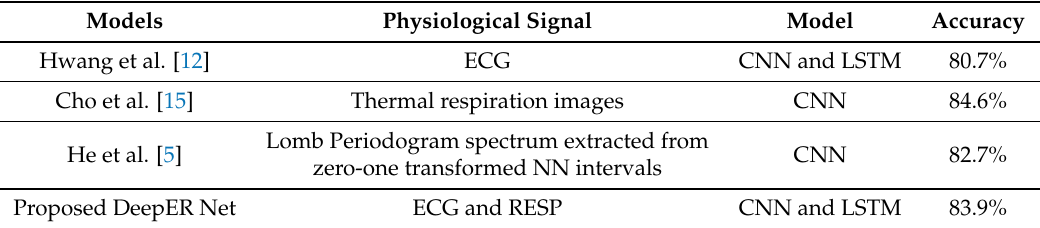
Comparison with the-state-of-the-art deep learning approaches using physiological signals for recognizing stress. Abbreviations: CNN, convolutional neural network; LSTM, long short-term